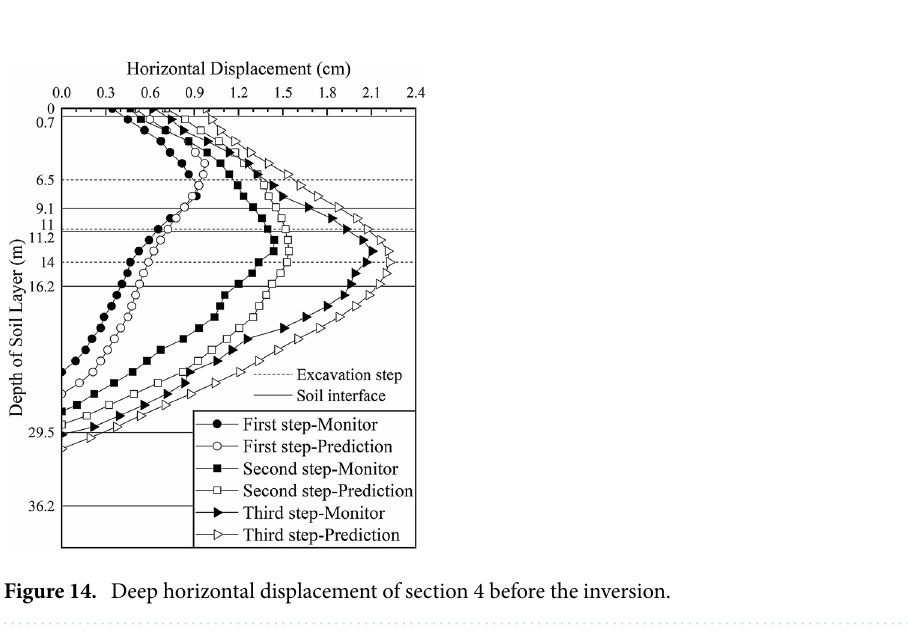
Figure 13. Deep horizontal displacement of section 3 after the inversion.